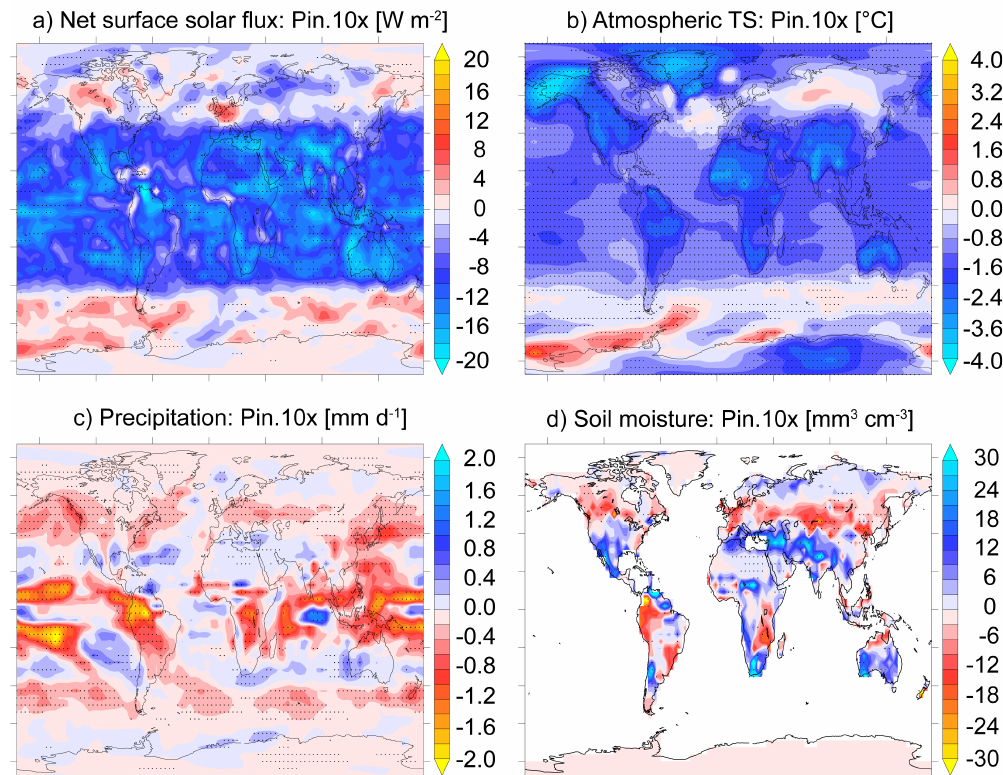
Fig. 5. Difference pattern between the Pin.10x case and the control simulation averaged over the first 5yr: (a) net surface solar flux changes, (b) atmospheric surface temperature changes, (c) precipitation changes, and (d) soil moisture changes. Stippling in (a–d) denotes grid cells where the changes are significant at the 5% level based on the two sided Student’s